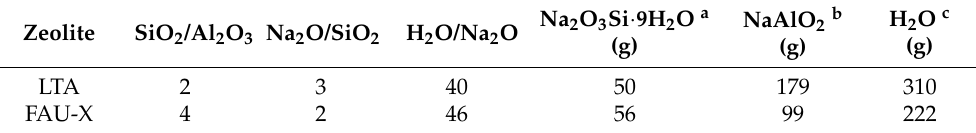
Table 1. Synthesis conditions for the preparation of zeolites LTA and FAU-X.